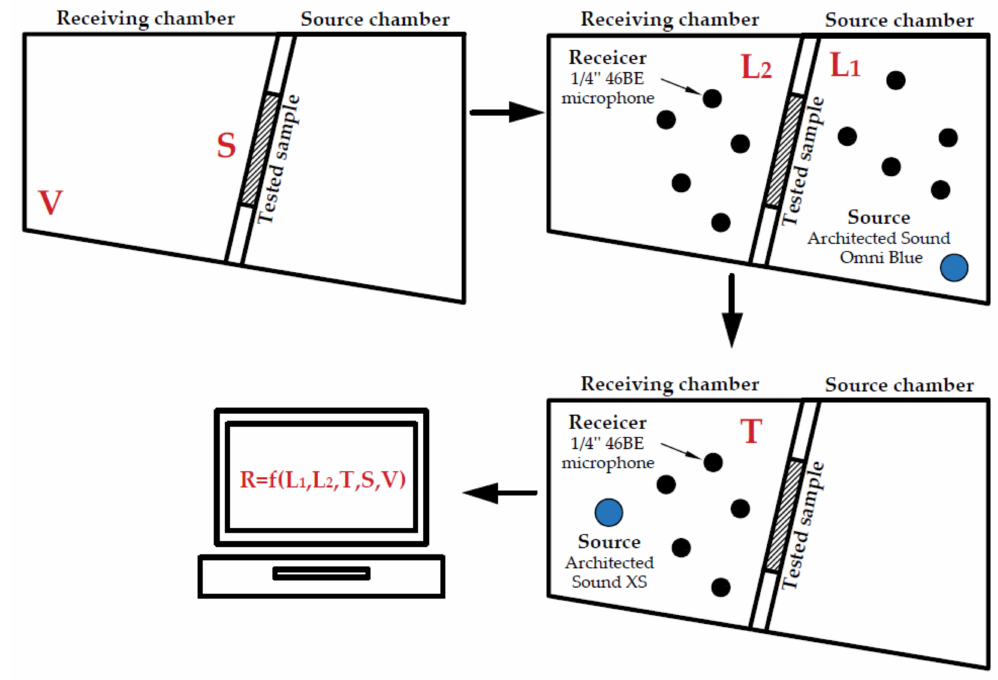
Figure 4. The flowchart of measurement methodology—subsequent stages of measurements and calculations of the parameters marked in red: sound pressure level in the source room ( L 1 ) and in the receiving room ( L 2 ), reverberation time in the receiving room ( T ), specimen surface area ( S ), receiving room volume ( V ), and airborne sound insulation of a specimen ( R